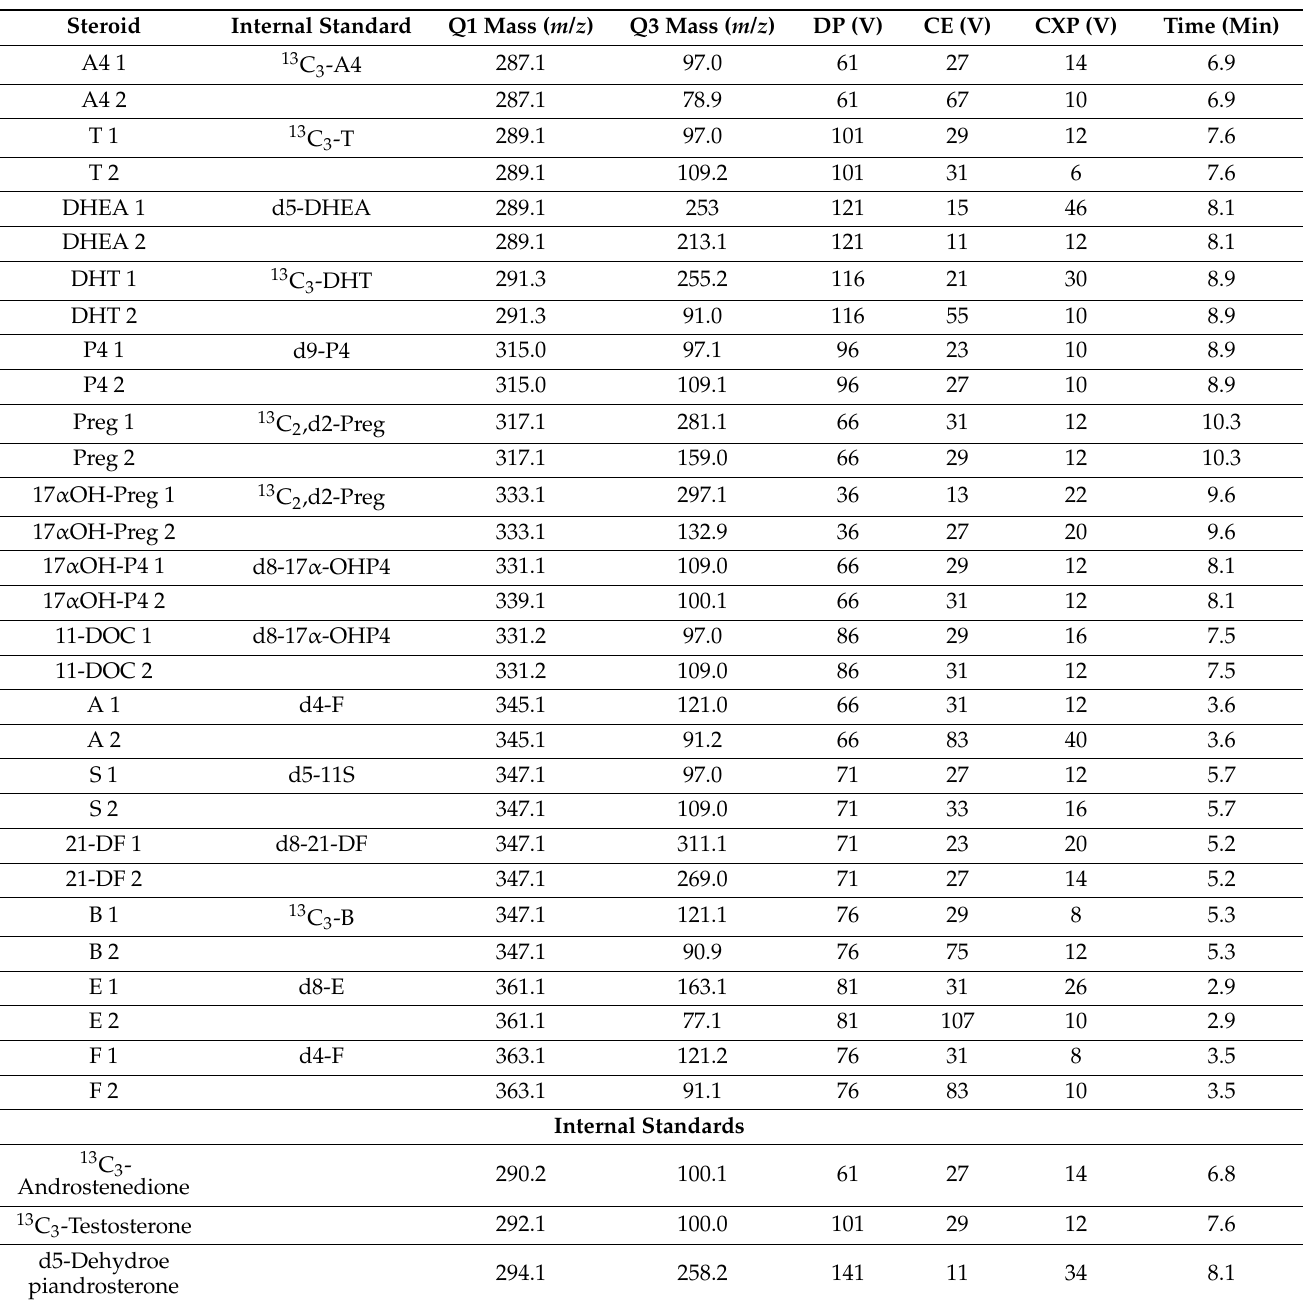
Table 1. Positive ion multiple reaction monitoring (MRM) parameters and retention times for each steroid and isotopically labelled internal standards, as analysed on a Kinetex C18 (150 × 2.1 mm; 2.6 µ m) column on an Acquity I-Class UPLC and QTrap 6500+ mass spectrometer following electrospray ionisation.